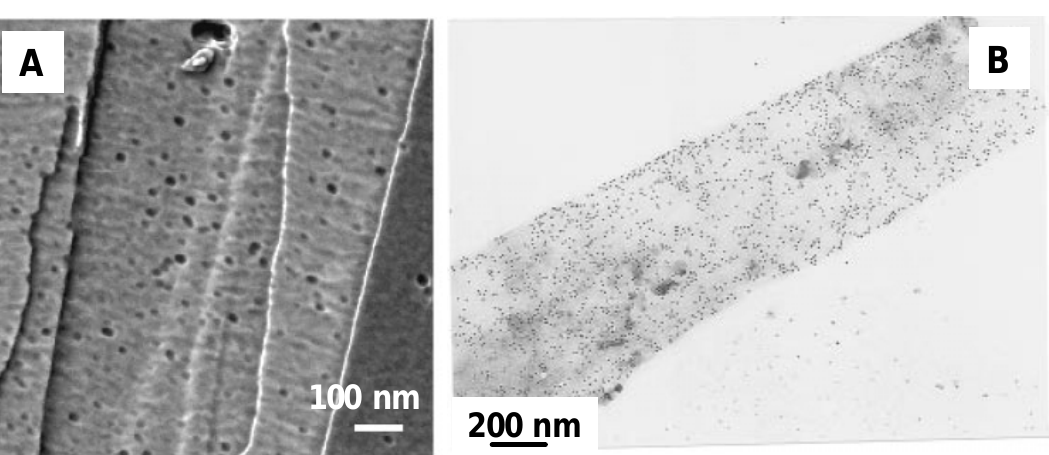
Figure 5. PHA depolymerases from R . pickettii T1 adsorbed on the surface of P(3HB) single crystals [37,42]. (A) AFM phase image of the PHA depolymerase on P(3HB) single crystal in air. (B) Visualization of the adsorption on P(3HB) single crystal by gold labeling and transmission electron microscopy. Reproduced with permission from Numata et al . and Iwata et al ., Macromol. Biosci . and Macromolecules ; published by Wiley-VCH Verlag GmbH & Co. KGaA and ACS, 2006 and